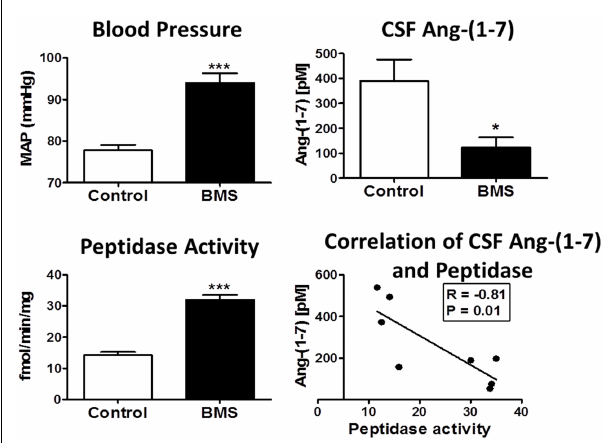
FIGURE 4 | Betamethasone-exposed (BMS) offspring exhibit higher mean arterial pressure (MAP) and CSF endopeptidase activity than non-exposed sheep . Blood pressure (MAP) was higher in BMS animals at 6months of age. CSF peptidase activity was twofold higher in BMS animals as compared to controls. CSF Ang-(1–7) peptide levels were lower in BMS animals. Ang-(1–7) peptide levels negatively correlate with peptidase activity in the CSF ( r =− 0.81, P = 0.01). Data are mean ± SEM; 4–5 per group; * P < 0.05 or *** P < 0.001 vs. controls. Adapted from Marshall et al.